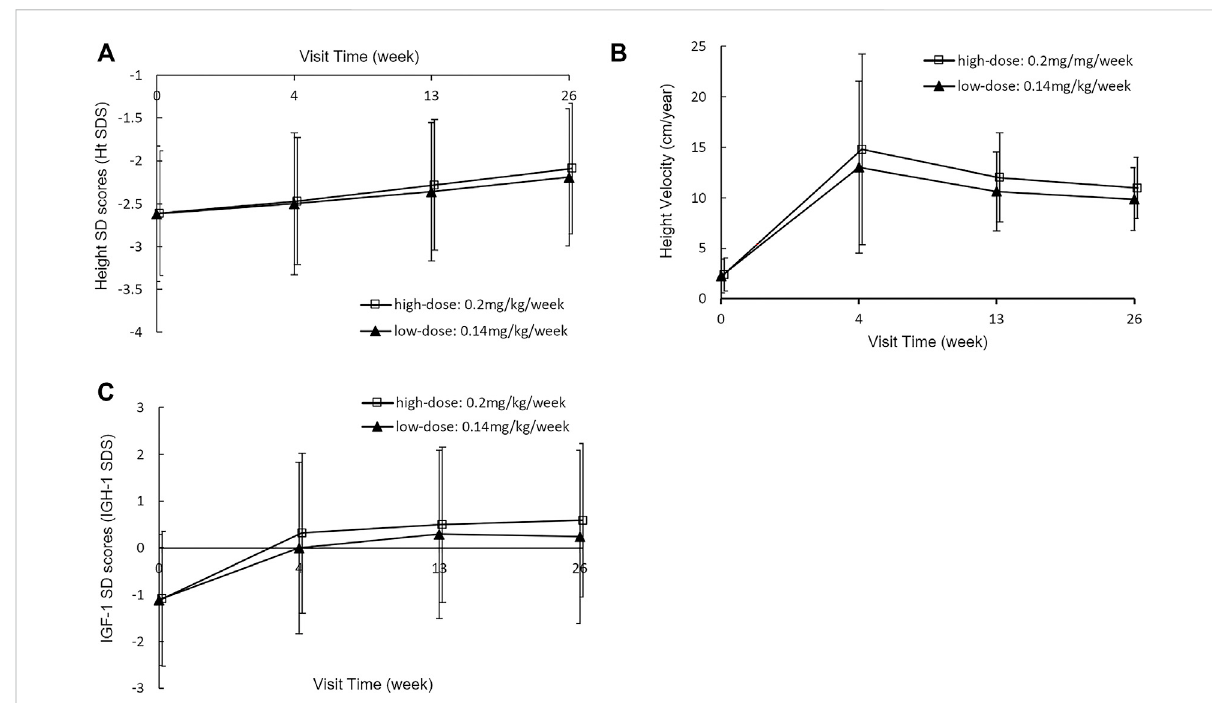
FIGURE 2 Height SDS (A) , Height velocity (B) and IGF-1 SDS (C) at baseline and week 4, 13 and 26 with a PEG-rhGH dose of 0.14 mg/kg/week or 0.2